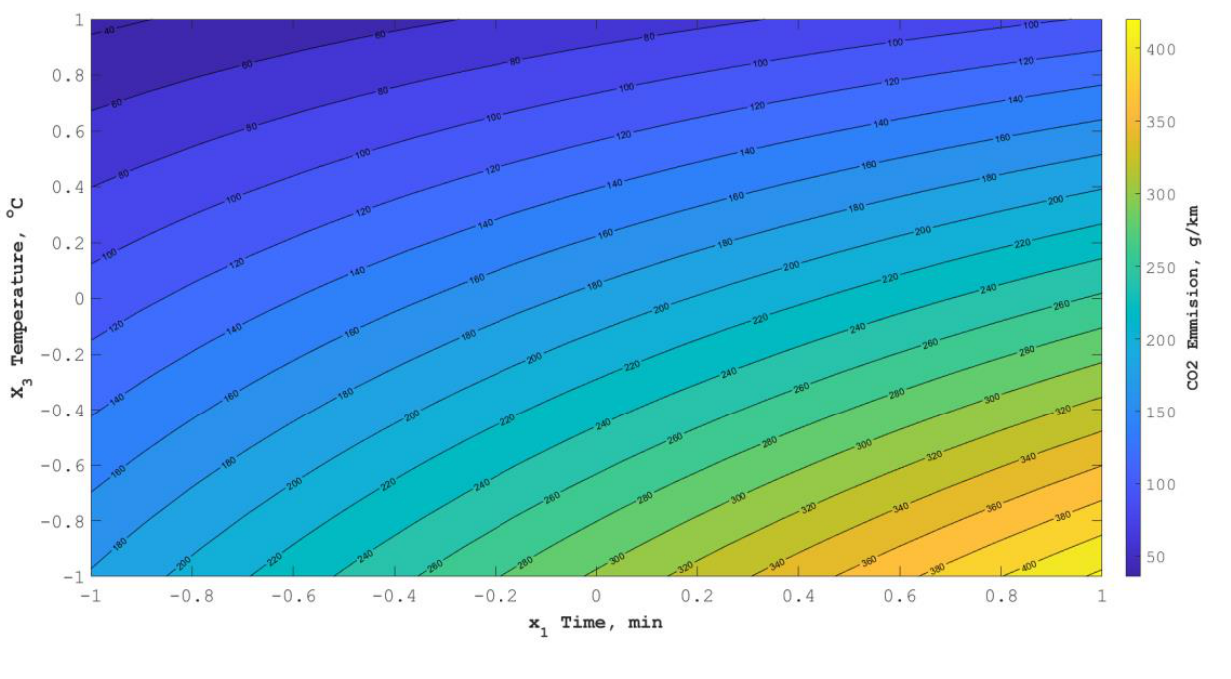
Figure 16. Change in CO 2 emissions depending on the variability of factors x 1 and x 3 for a vehicle (EV) covering a distance of 4 km (x 2 = 1).